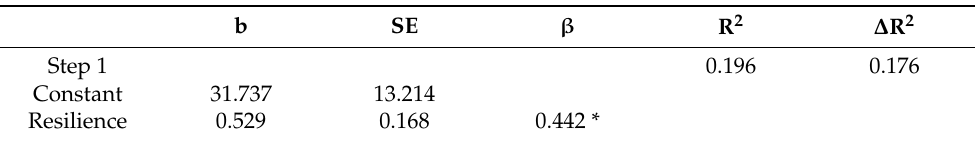
Table 7. Univariate linear regression analysis predicting posttraumatic growth from resilience for living donor recipients.